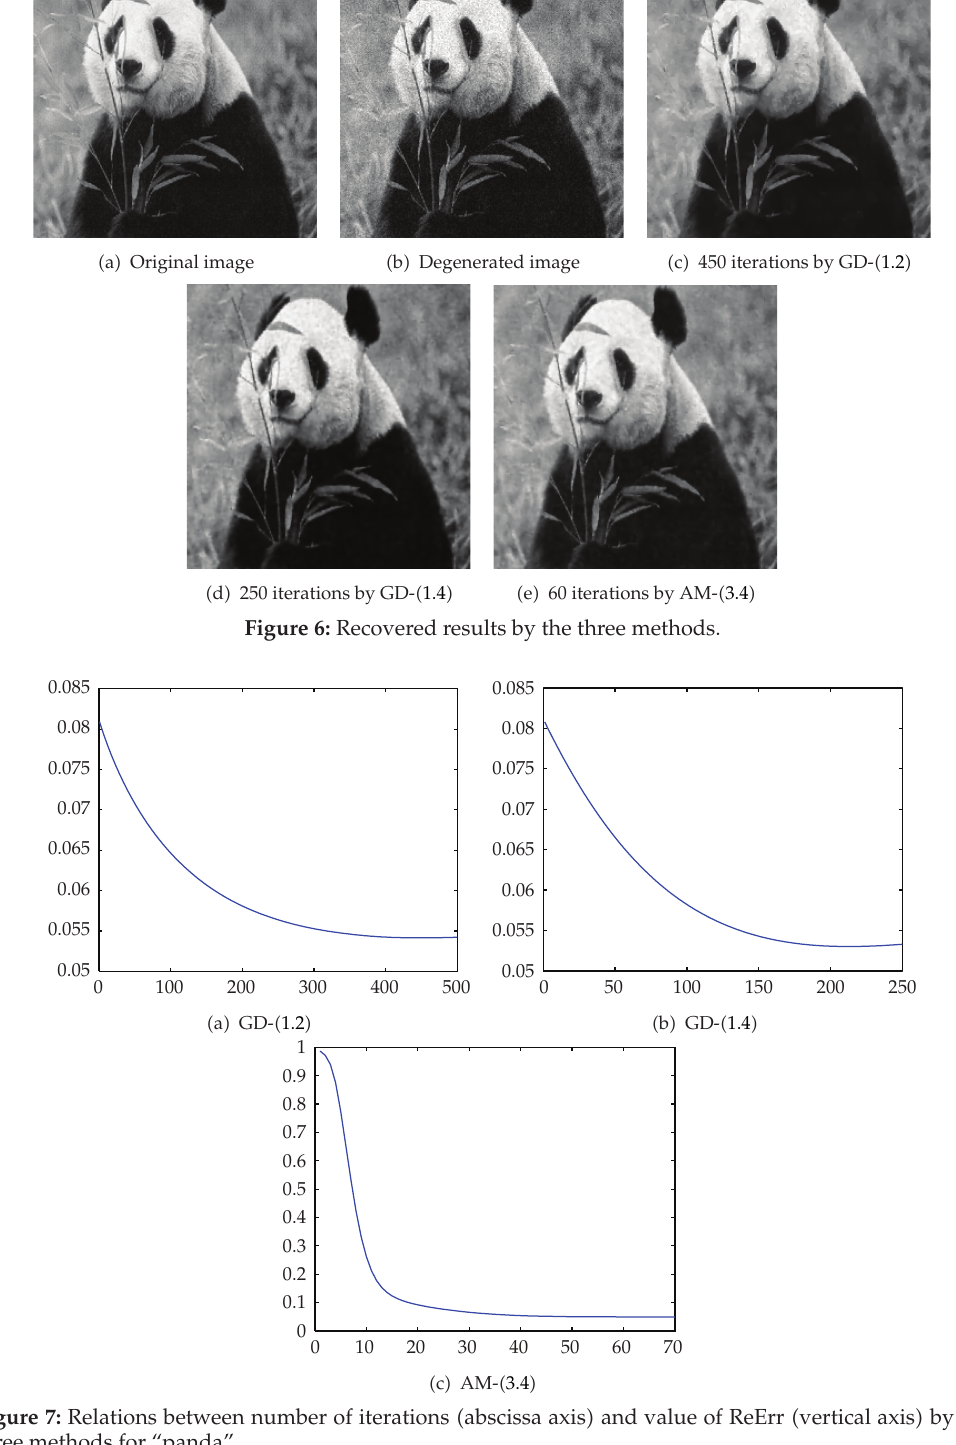
Figure 7: Relations between number of iterations (cid:3) abscissa axis (cid:4) and value of ReErr (cid:3) vertical axis (cid:4) by the three methods for